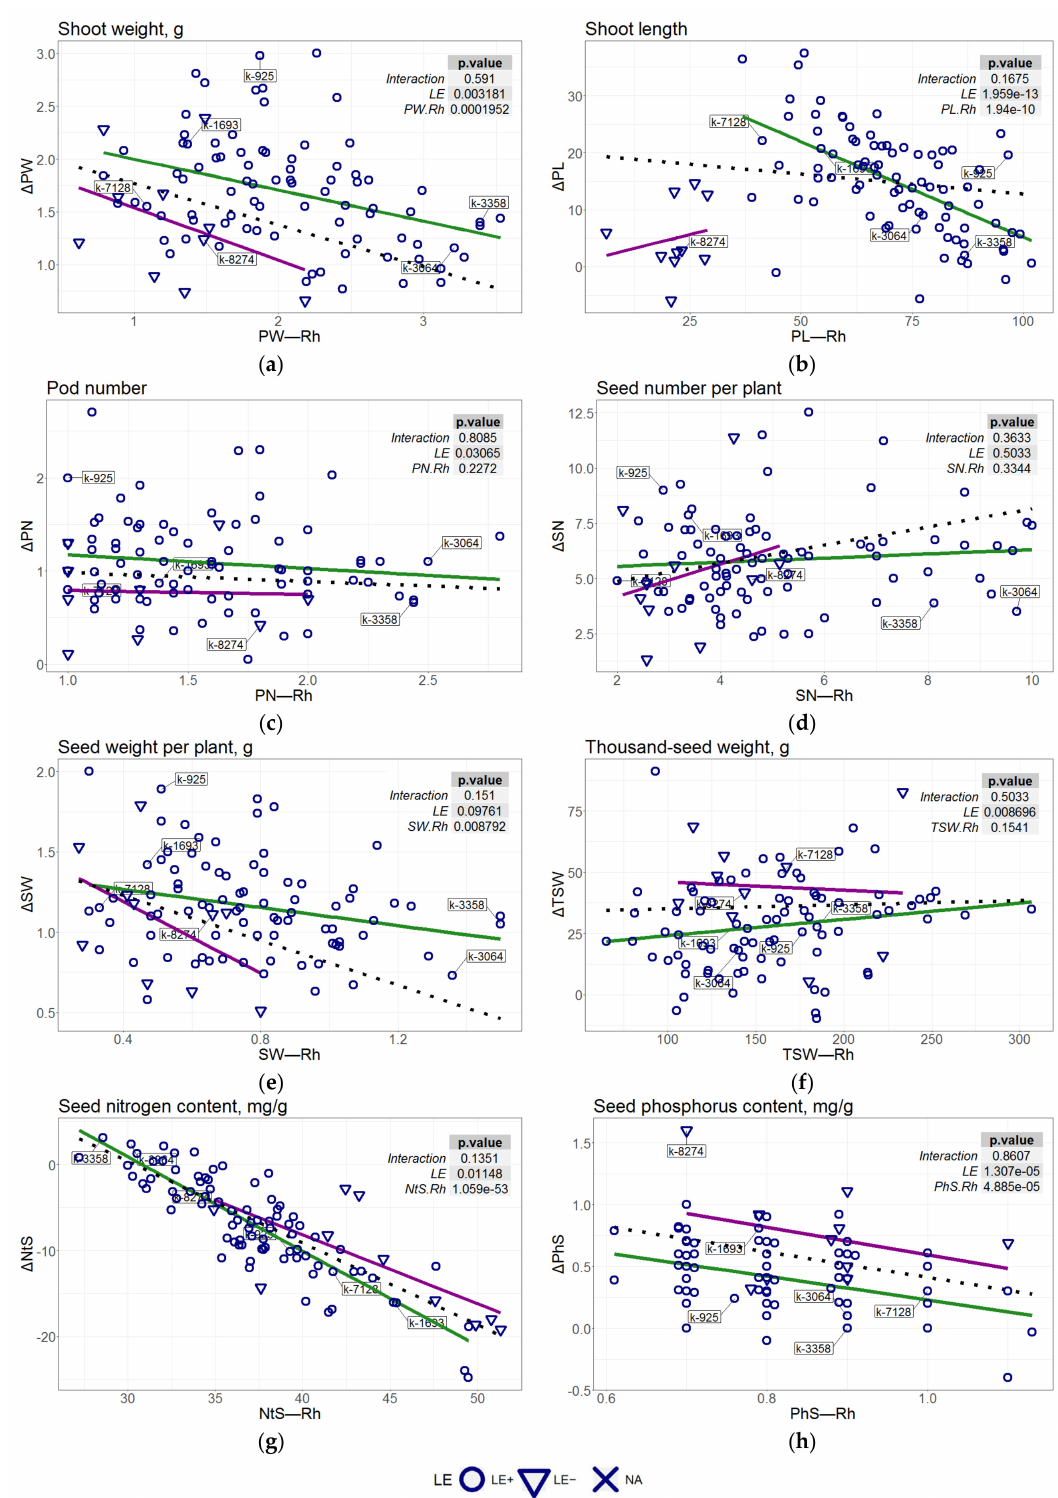
Figure 4. Scatterplots of AM-caused trait increments ( ∆ T, y -axis) against trait values of plants grown under single inoculation with rhizobia (T Rh , x -axis). The lines represent the approximation of the two-variable regression model with variable interaction ( ∆ T~T Rh * LE); the green line is for LE+ cultivars, the purple line is for LE- cultivars, and the dotted line represents ∆ T~T Rh dependency excluding LE factor. In the tables, the results of statistical tests for significance of two factors, T Rh and LE, and their interaction are presented. The following traits are shown: ( a ) PW—shoot weight, g; ( b ) PL—shoot length, cm; ( c ) PN—pod number; ( d ) SN—seed number per plant; ( e ) SW—seed weight per plant, g; ( f ) TSW—thousand-seed weight, g; ( g ) NtS—seed nitrogen content, mg/g; ( h ) PhS—seed phosphorus content,